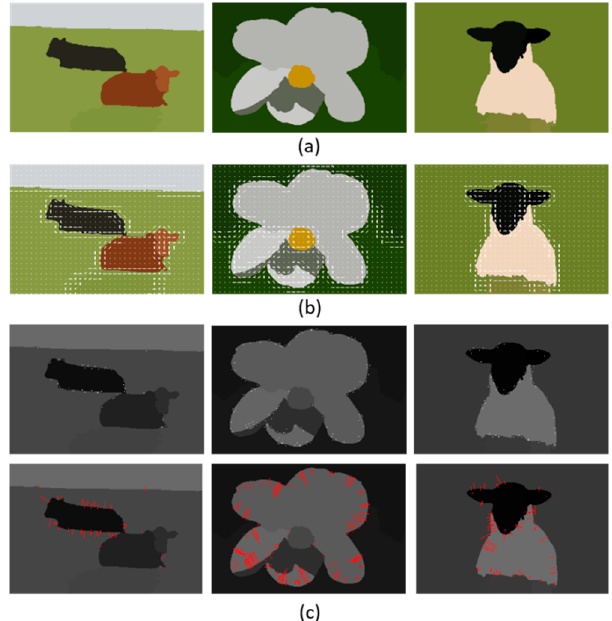
Figure 7. Local feature descriptor, ( a ) original images, ( b ) HOG feature extraction and ( c ) SIFT feature extraction results over MSRC dataset. The 1st row shows the locations while the 2nd row shows the scale and orientation of key points.